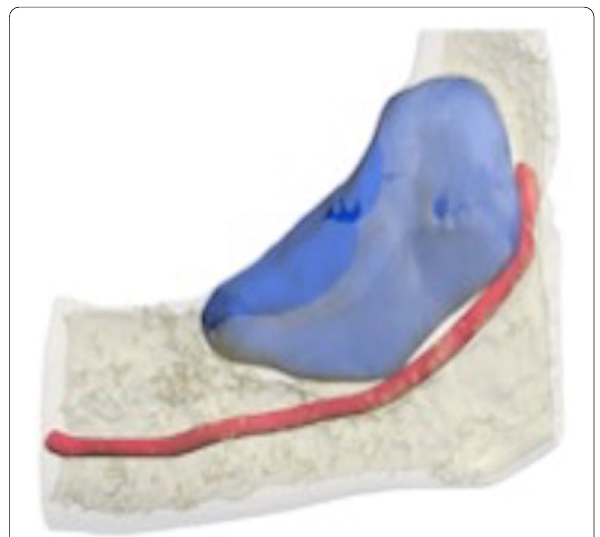
Fig. 5 3D reconstruction of the